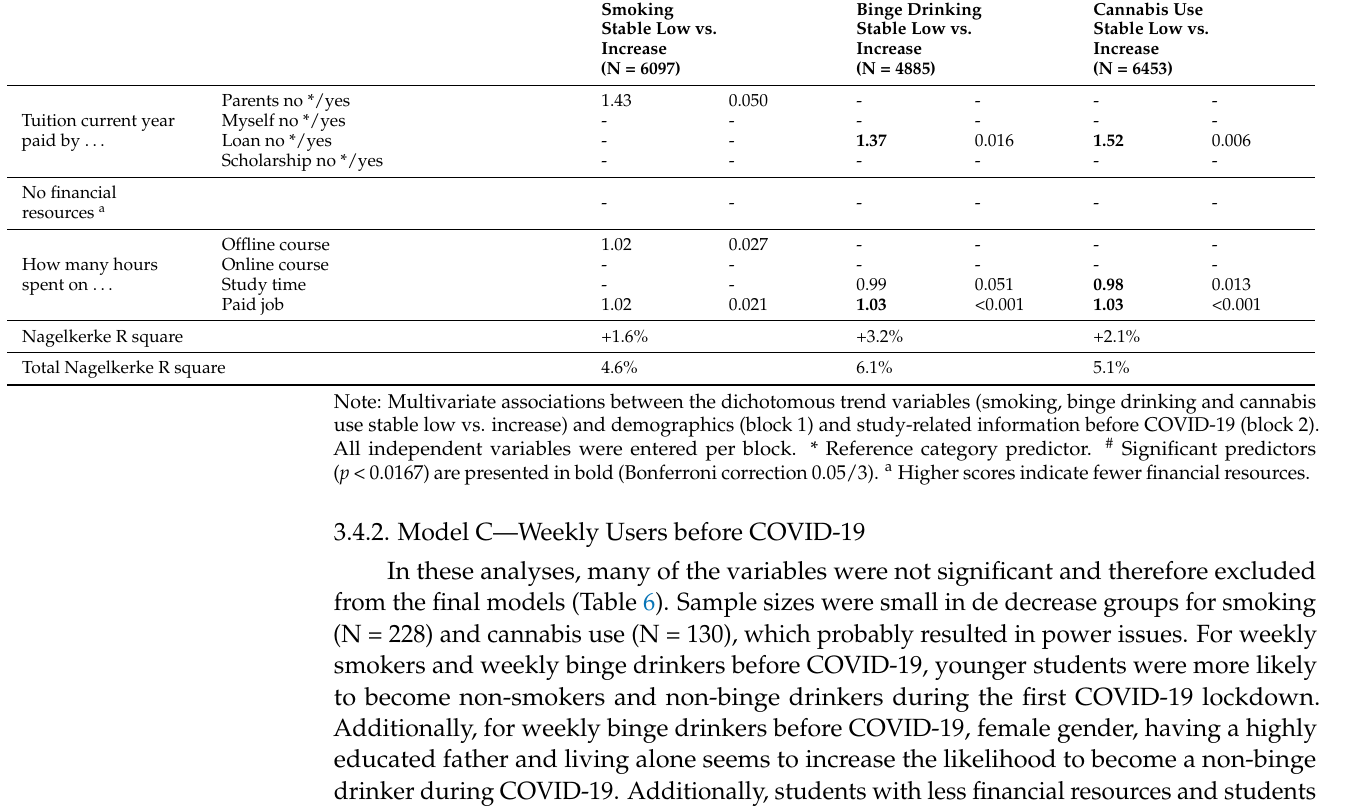
Binge Drinking Stable Low vs.